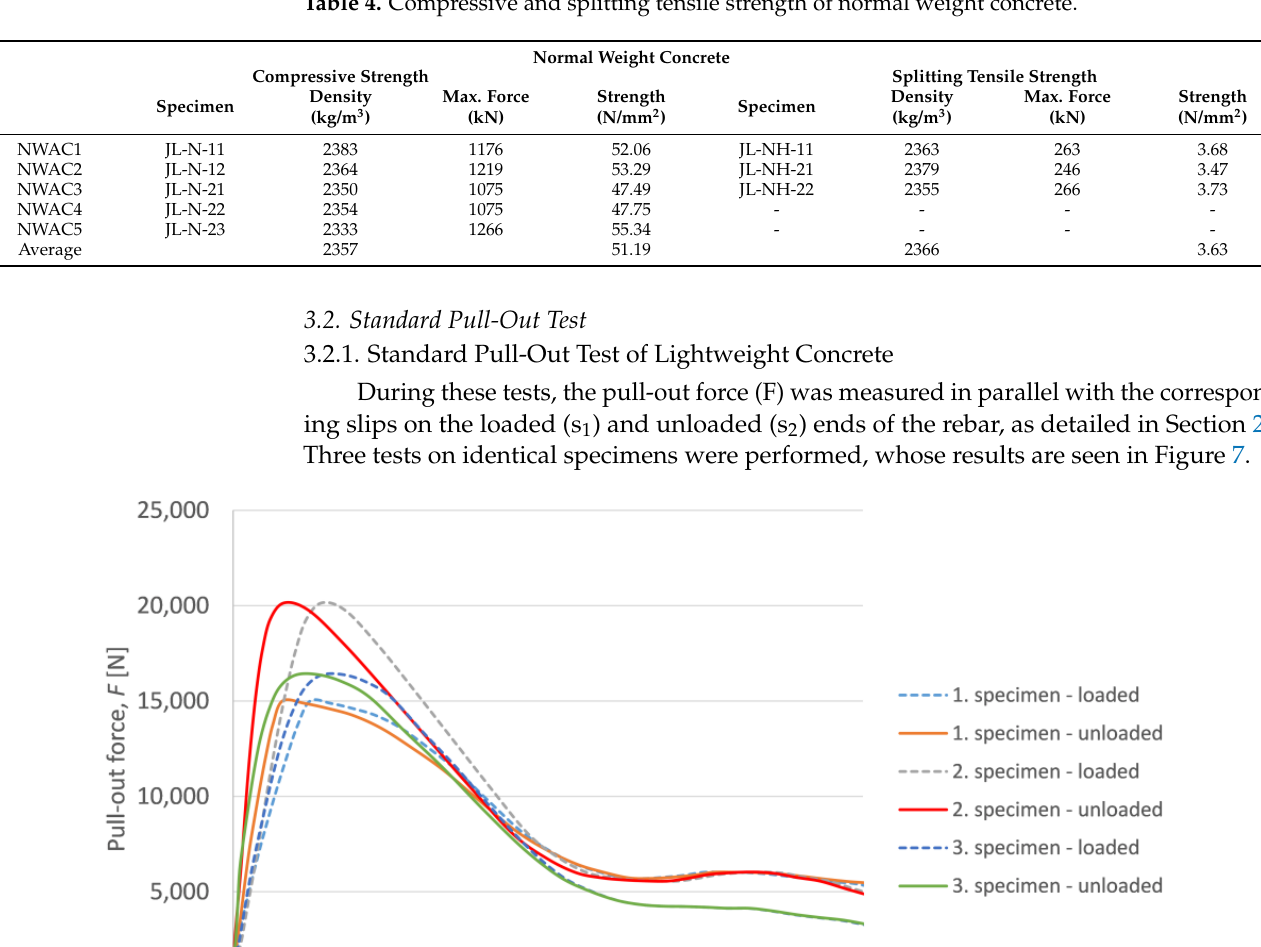
Table 4. Compressive and splitting tensile strength of normal weight concrete.